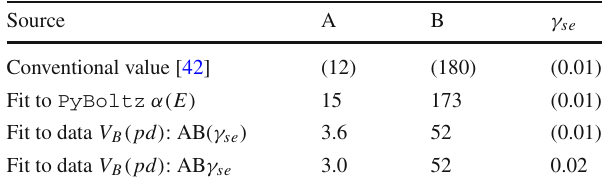
Table1 A , B and γ coefficientsfromvariousdescriptionsofthebreak- down voltage in terms of the Paschen–Townsend parameterization. Numbers in (brackets) are fixed constants, whereas those without are fit results. The first row shows the conventional values from Ref. [42]. The second row shows the result of fitting the Townsend approximation Eq. 2 to PyBoltz predictions of α( E ) for argon. The third and forth rows show the result of fitting the Paschen curve to data directly, either with or without γ se as a free parameter; in practice these two models are nearly indistinguishable. None of these models fits the data well over all pd values as well as the PyBoltz -Townsend model, which predicts α( E ) directly rather than relying on A and B